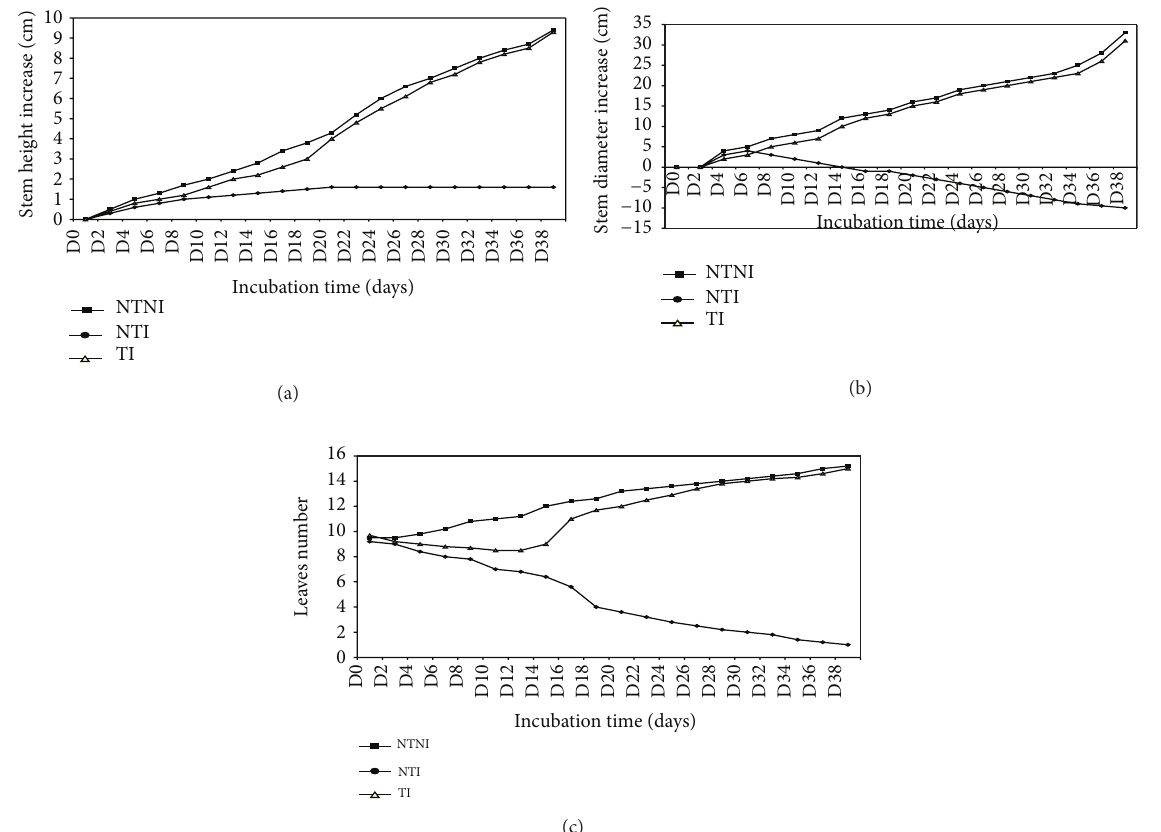
Figure 3: Protective effect of exogenously applied MeJA on cotton against fusarium wilt caused by Fusarium oxysporum f. sp. vasinfectum . Prior to inoculation, leaves were treated with MeJA 5.0 mM and were incubated at 72 h (0 day) at 25 ∘ C for 38 days. Disease severity was evaluated by noting every two days the stem height (a) and diameter increase (b) as well as the number of healthy attached leaves (c). TI: MeJA/infected plants; NTI: no-MeJA/infected plants; NTNI: no-MeJA/no-infected